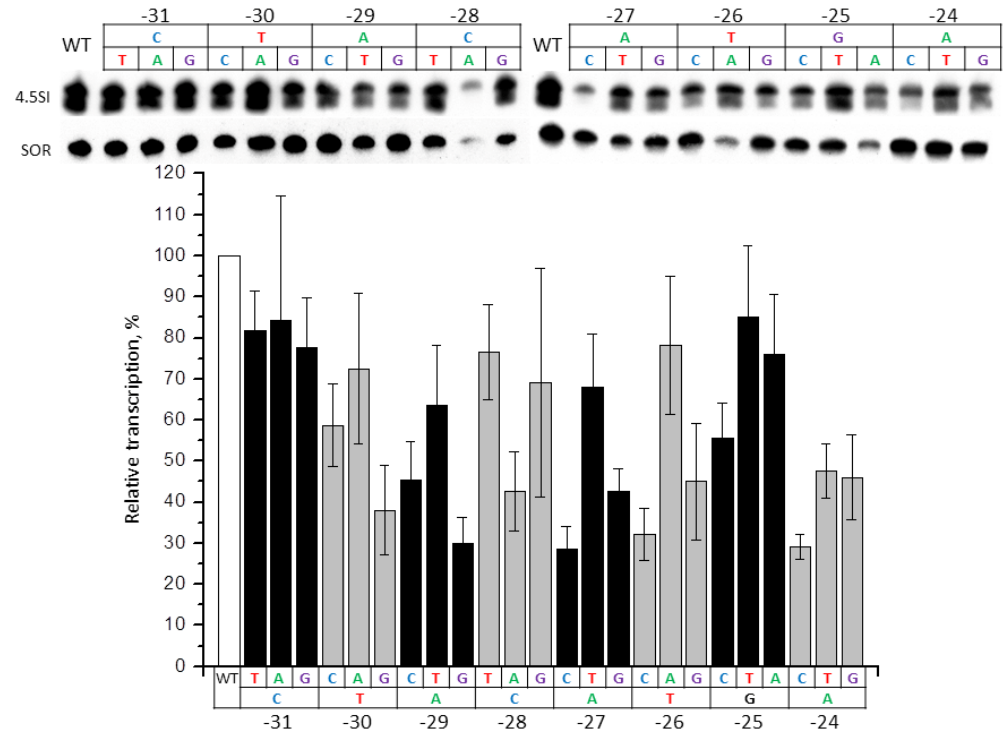
Figure 5. E ff ect of single nucleotide substitutions in box − 31 / − 24 of the murine 4.5SI RNA gene on its transcription. Upper panel: 4.5SI-gene transcripts detected by Northern hybridization in cells transfected by constructs with the replacement of each nucleotide by three other ones in the − 31 / − 24 box. SOR SINE was transfected along with the 4.5SI RNA gene, and used as a control. Lower panel: quantitative analysis of the Northern hybridization data. The level of gene transcription without nucleotide substitutions (WT) is taken as 100% (error bars, SD, n = 4).